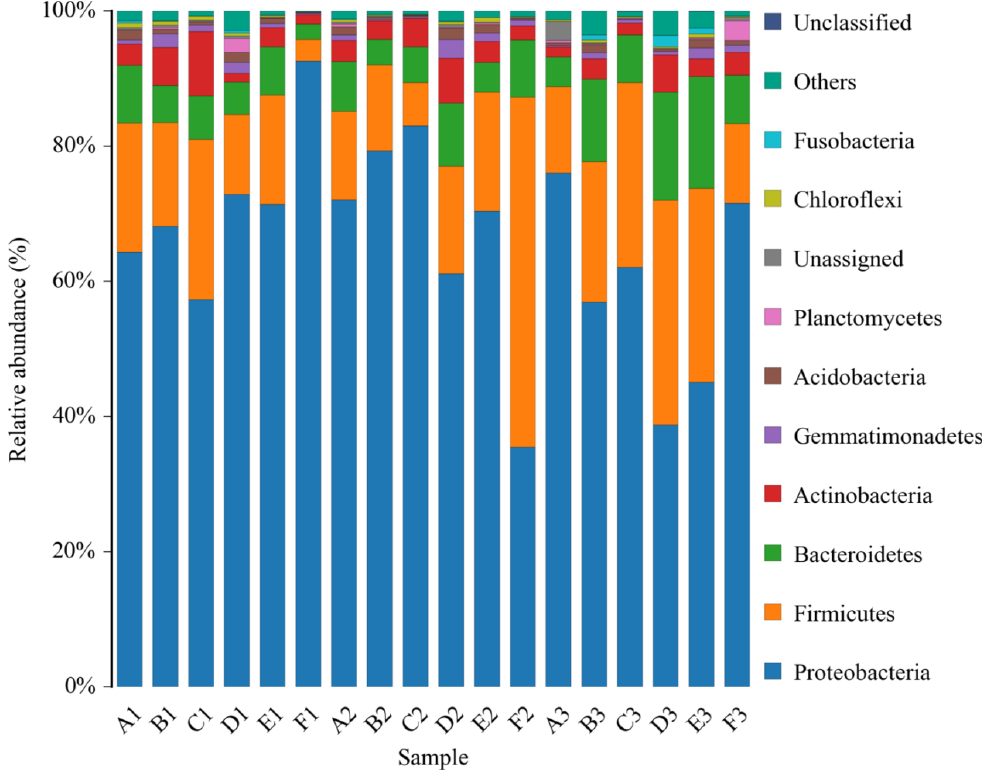
Figure 4. Bacterial Phyla distribution in the samples.